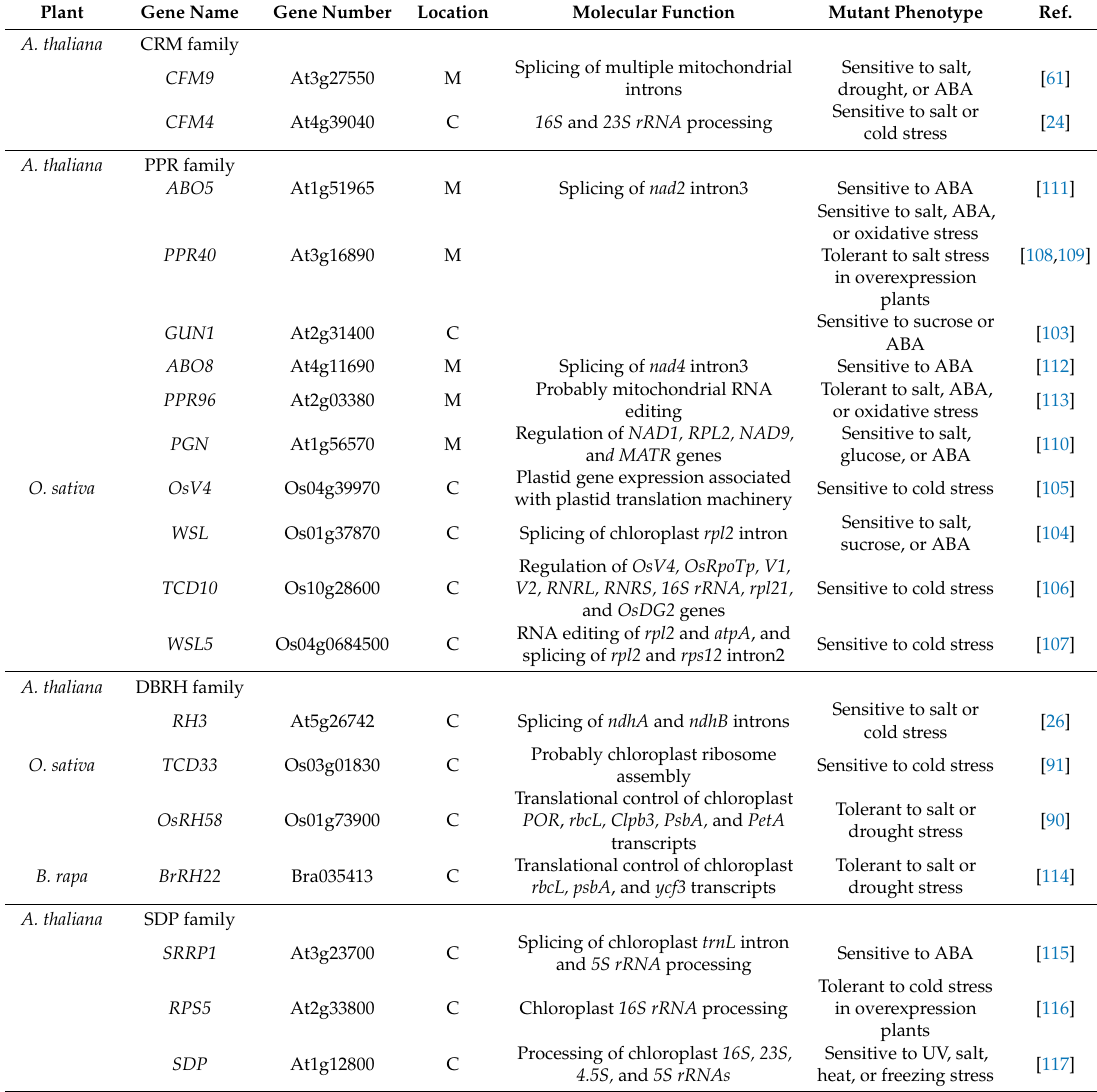
Table 2. Phenotypes and functions of CRM, PPR, DBRH, and SDP proteins in abiotic stress